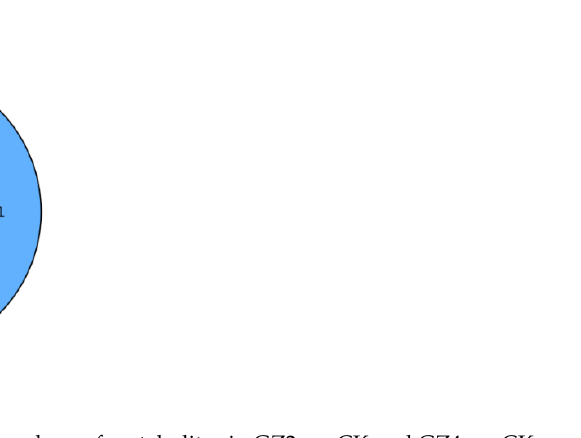
Figure 5. Volcano maps of differential metabolites. ( a ) GZ2 vs. CK; ( b ) GZ4 vs. CK; ( c ) GZ4 vs. GZ2.